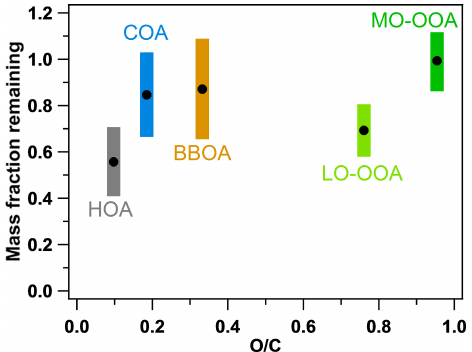
Figure 7. Comparison of the volatilities (MFRs at 50 ◦ C) and O / C ratios of the five OA factors in this study. The colorful regions indicate the SDs of the